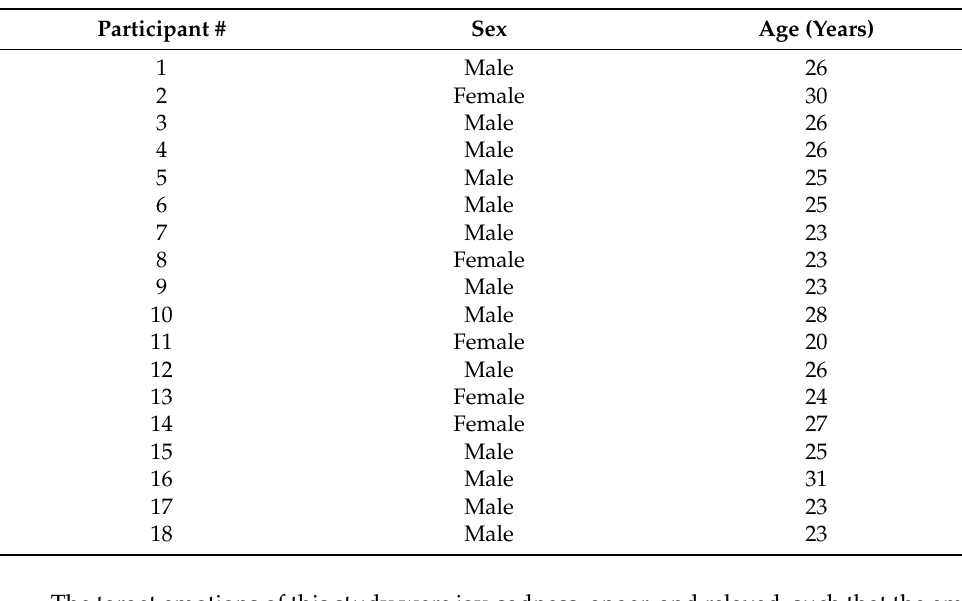
Table 1. Participant information.